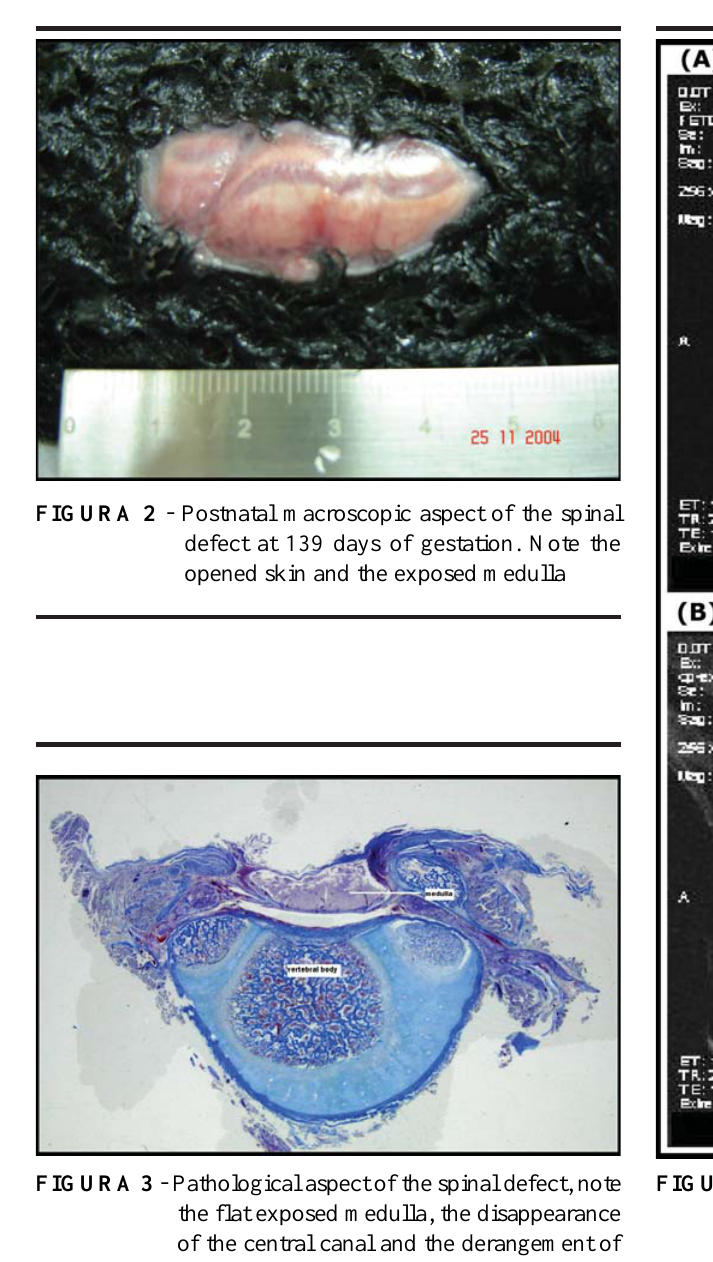
FIGURA 3 - Pathological aspect of the spinal defect, note the flat exposed medulla, the disappearance of the central canal and the derangement of normal citoarchitecture of the medulla